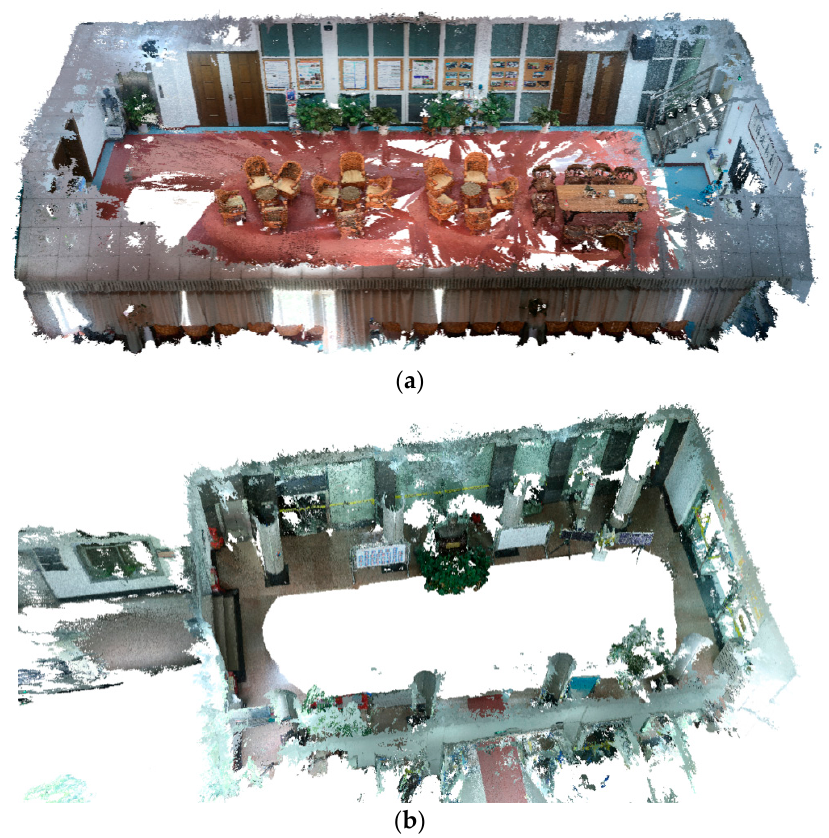
Figure 11 . Dense 3D point model reconstruction: ( a ) Meeting room; ( b ) Lobby. Figure 11. Dense 3D point model reconstruction: ( a ) Meeting room; ( b )